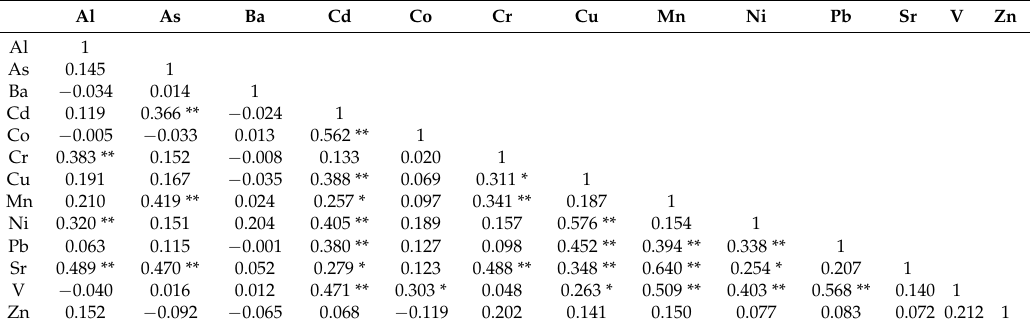
Table 2. Correlation between heavy metals in PM 2.5 (n = 65).